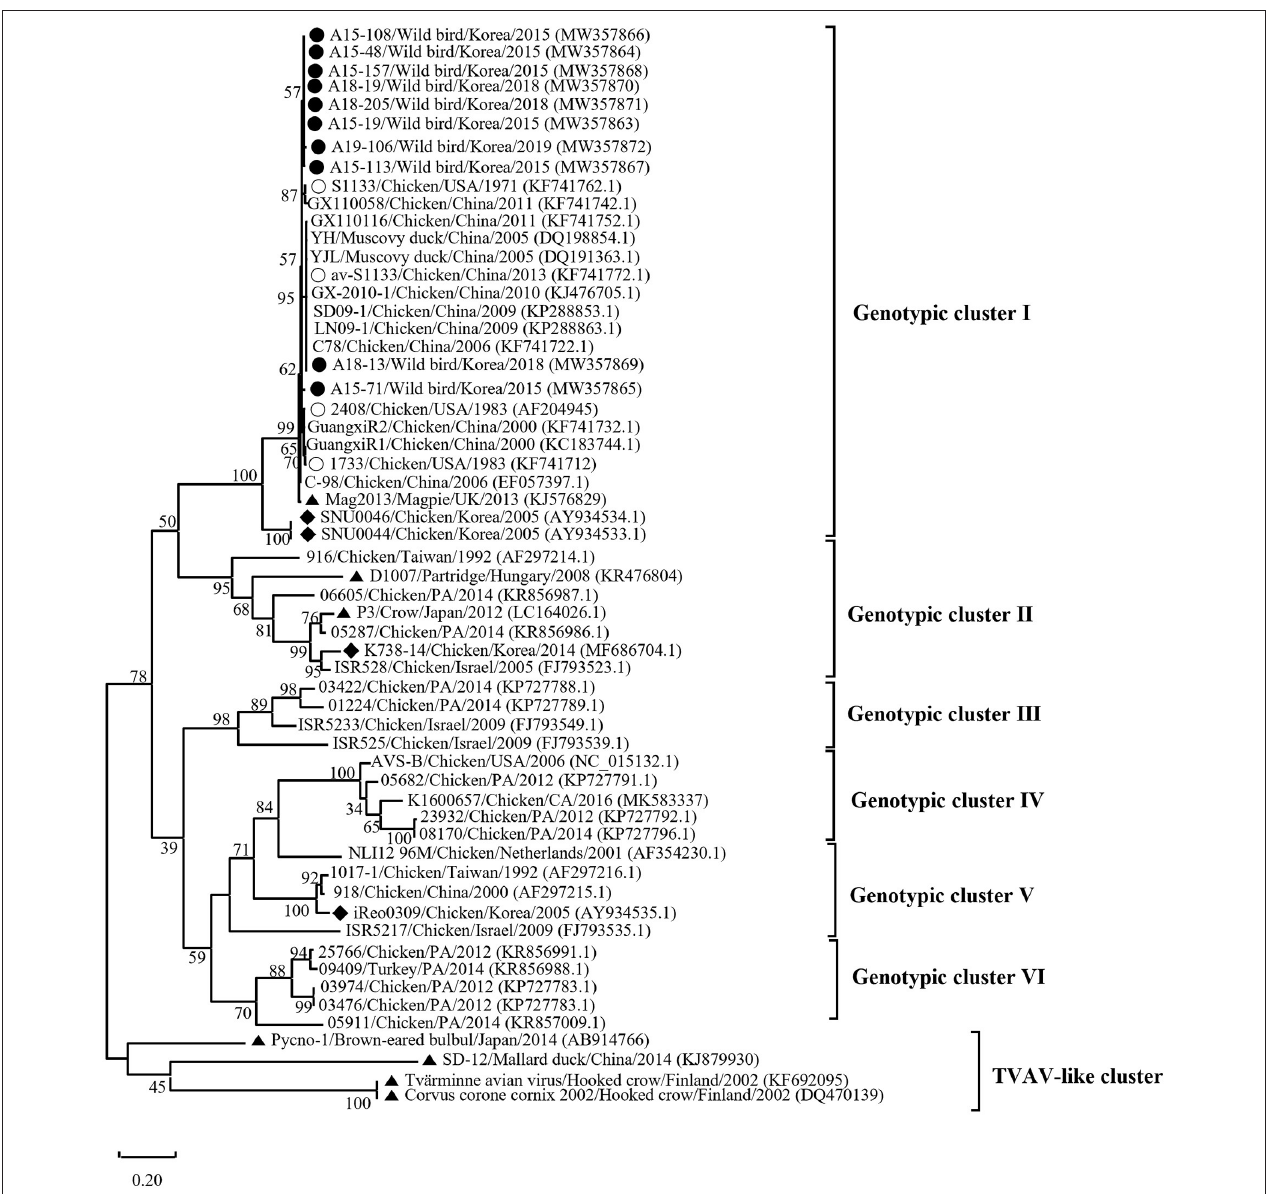
FIGURE 3 | Phylogenetic tree of ARV isolates based on the deduced amino acid sequences of the σ C-encoding gene. Maximum likelihood phylogenetic analyses were conducted using MEGA-X software with the Jones–Taylor–Thornton (JTT) model and 1,000 bootstrap replicates. The tree shows genetic relationship between the σ C protein sequences (326 amino acids) of our 10 isolates and 48 reference isolates that were isolated from around the world. The virus isolates are clustered into six genotypic clusters. The black circle (•) indicates our isolates, and the white circle ( ◦ ) indicates the vaccine isolates. Additionally, the black diamond ( (cid:7) ) indicates field isolates in Korea, and the black triangle ( N ) indicates previously isolated wild bird isolates. Each sequence on the tree is identified by the isolate name, host, country of origin, year of isolation, and GenBank accession